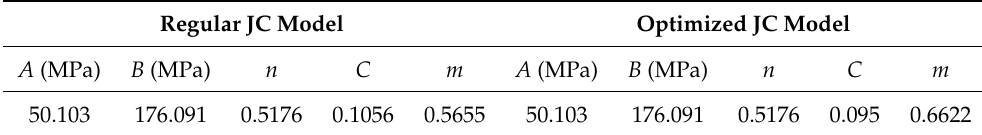
Table 2. Johnson-Cook material model parameters of AISI-1045